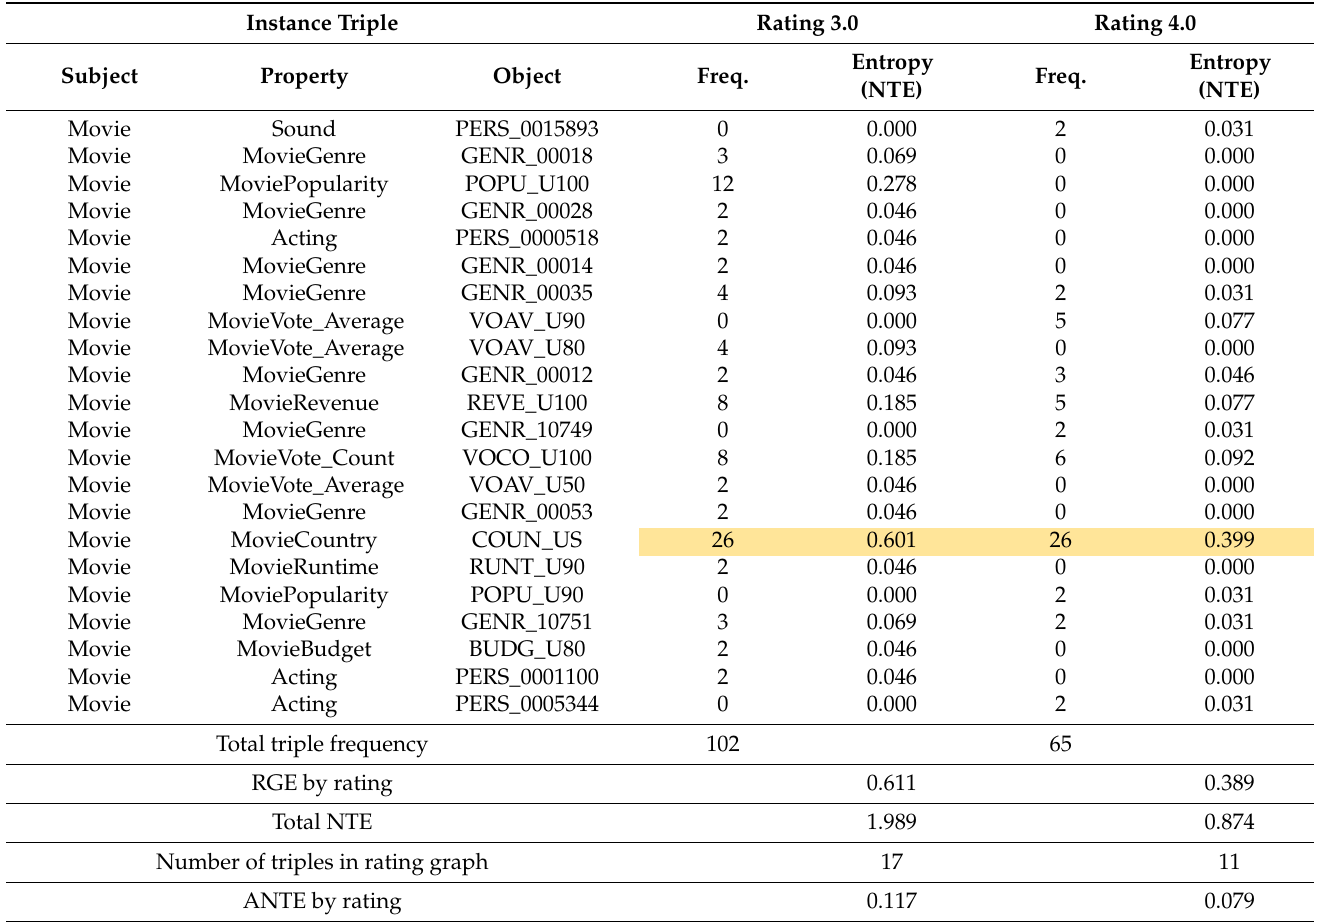
Table 3. Frequency and entropy of triple by